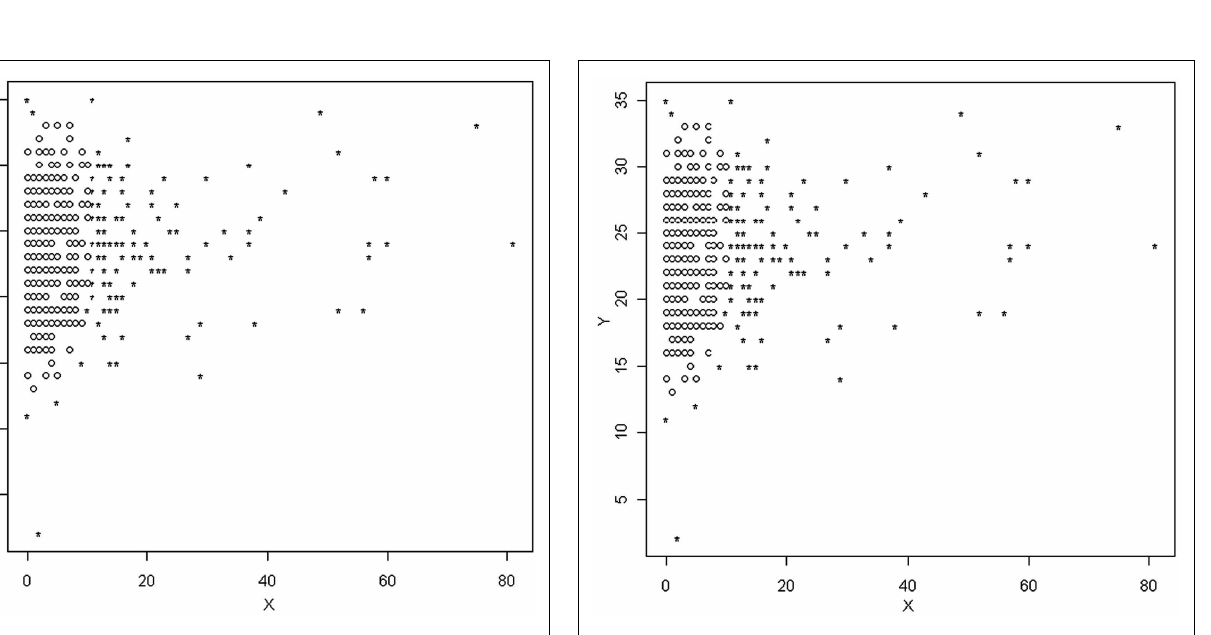
FIGURE 2 | Scatterplot of observations identified as outliers based on the MCD